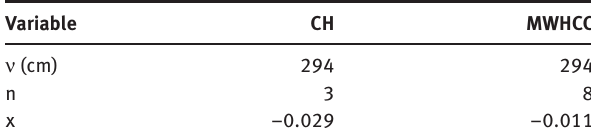
Table 6: The values of ν , n, and x for the TG transesterification under the MWHCC and CH